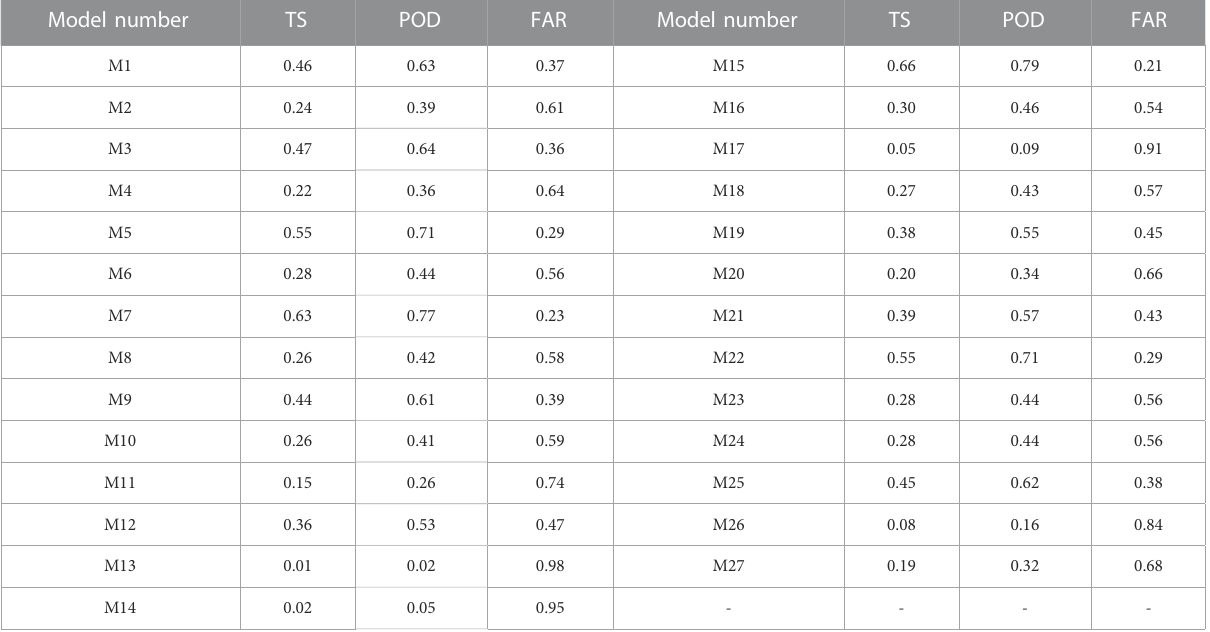
TABLE 4 Scores of evaluation metrics for total cumulative precipitation. Model